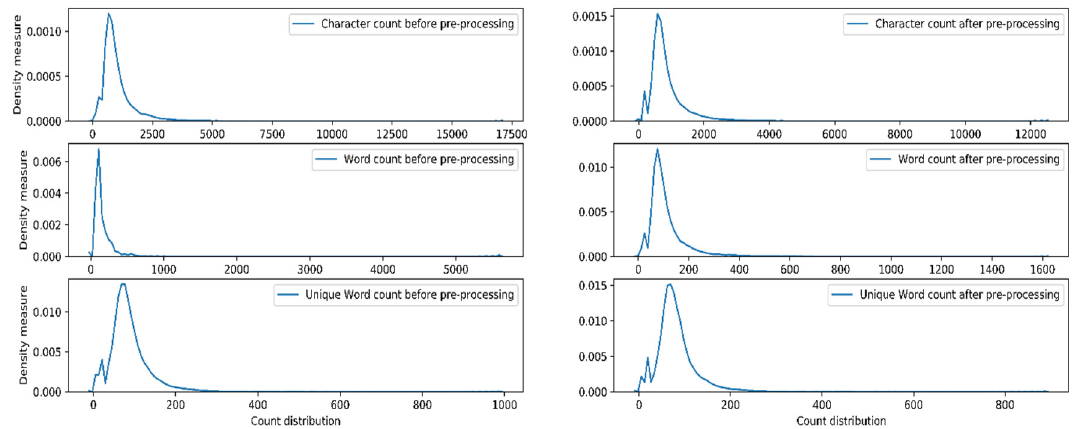
Figure 1. The distribution of character, word count, and unique word count of the histopathology reports before and after pre-processing.